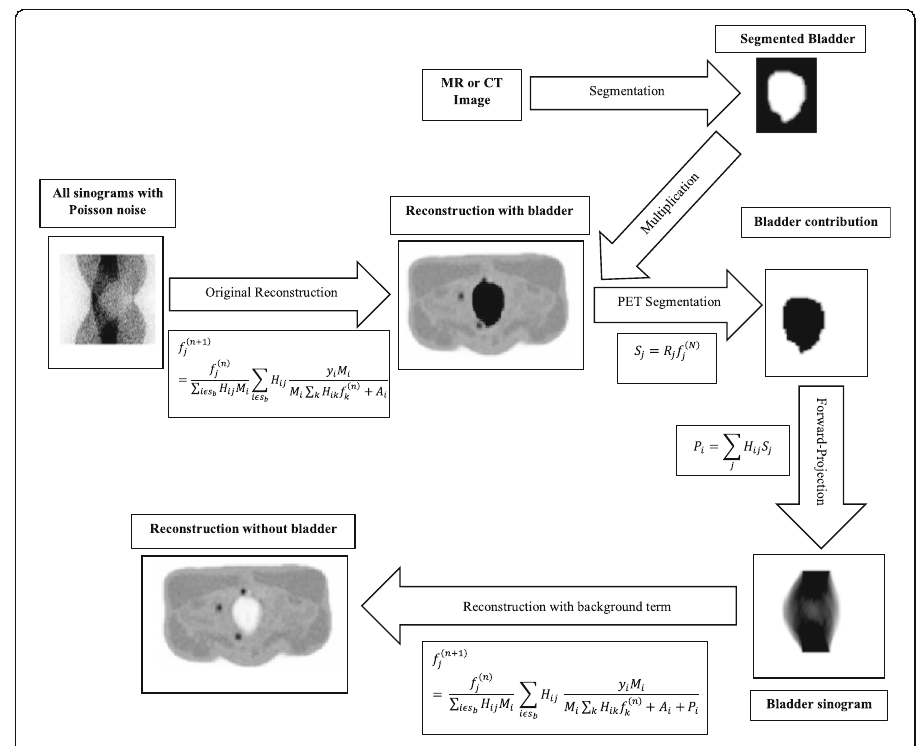
Fig. 3 Schematic description of the background correction technique, as demonstrated for the XCAT2 phantom simulation. In this study, the bladder was automatically segmented from the XCAT2 phantom, but in principle, the hot region can be segmented from either the CT or MR image